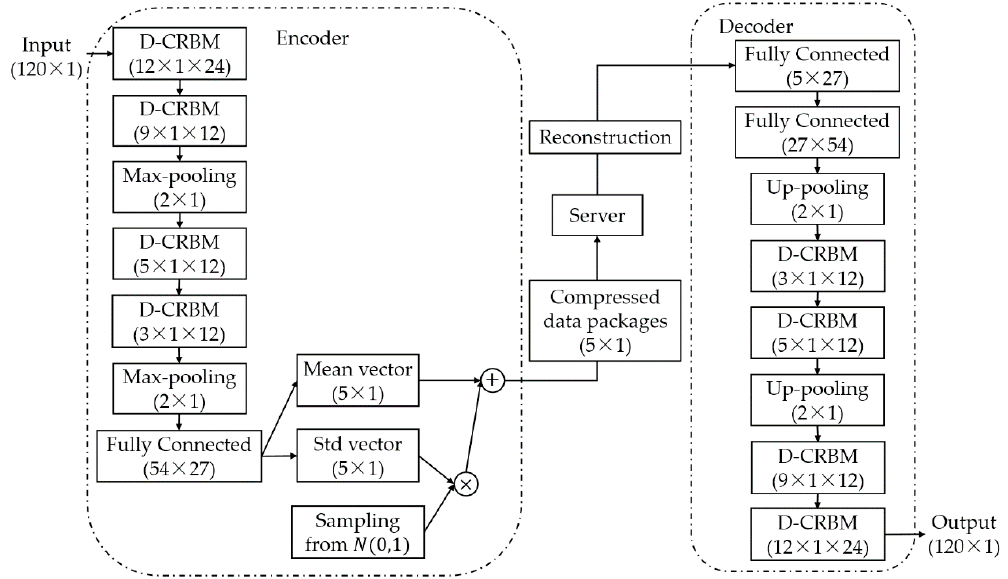
Figure 4. CBN-VAE model. The contents in the parentheses of the network layer (D-CRBM and Fully Connected) are the size of the layer kernel, and the contents in the parentheses of the vector (input and output, etc.) are the size of the vector. For Max-pooling and Up-pooling layers, the contents in the parentheses are the size of the sampling.